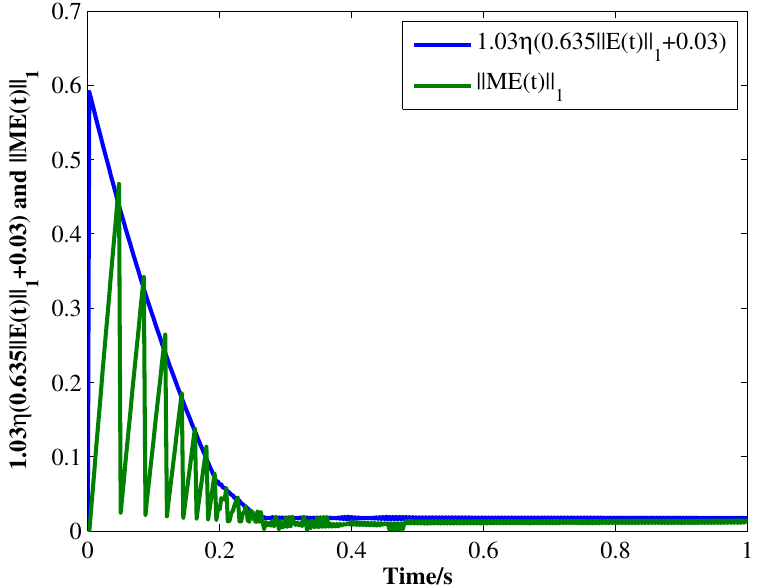
Figure 6. The relationship between 1 and Norm || ME ( t ) || 1 and the threshold